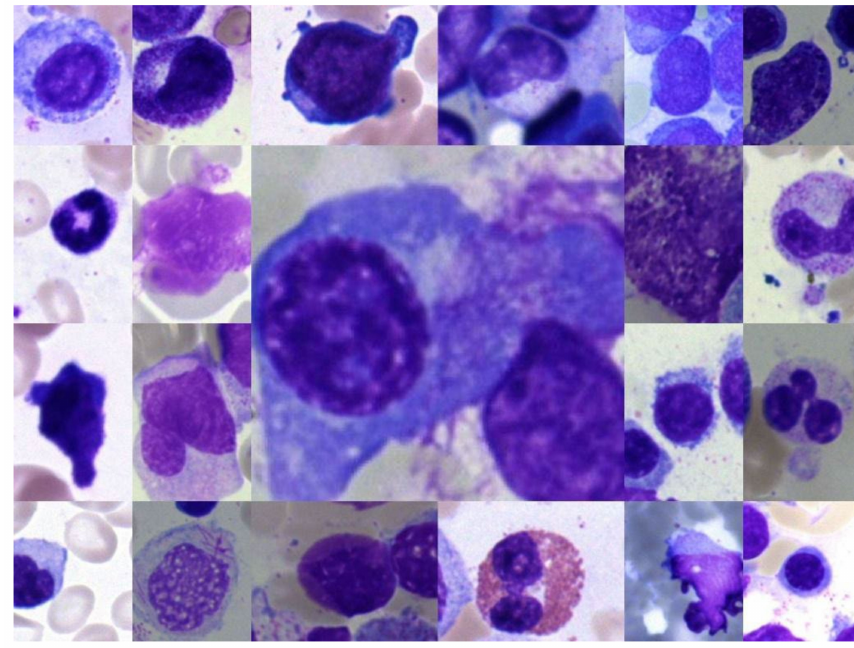
Figure 1. Bone marrow cells of 21 different classes.